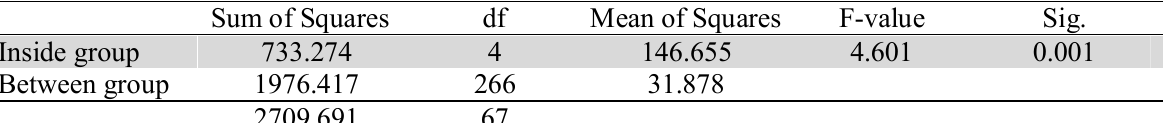
The results of testing the effect of age on product involvement in using mobile devices Sum of Squares